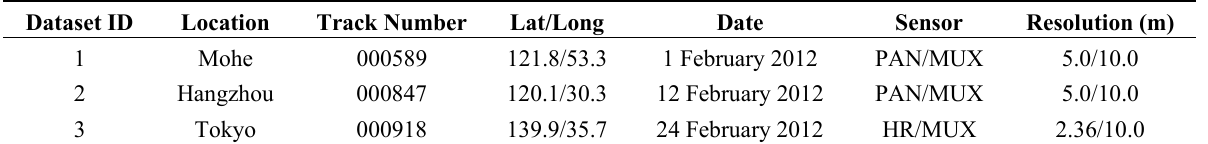
Table 1. Overview of test datasets.